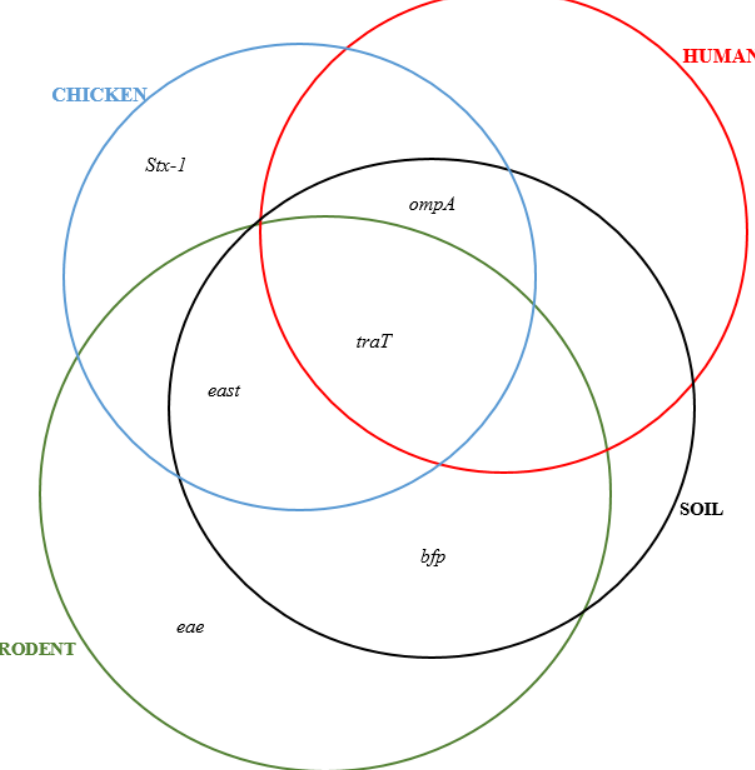
Figure 5. Distribution of virulence genes in various sample sources.